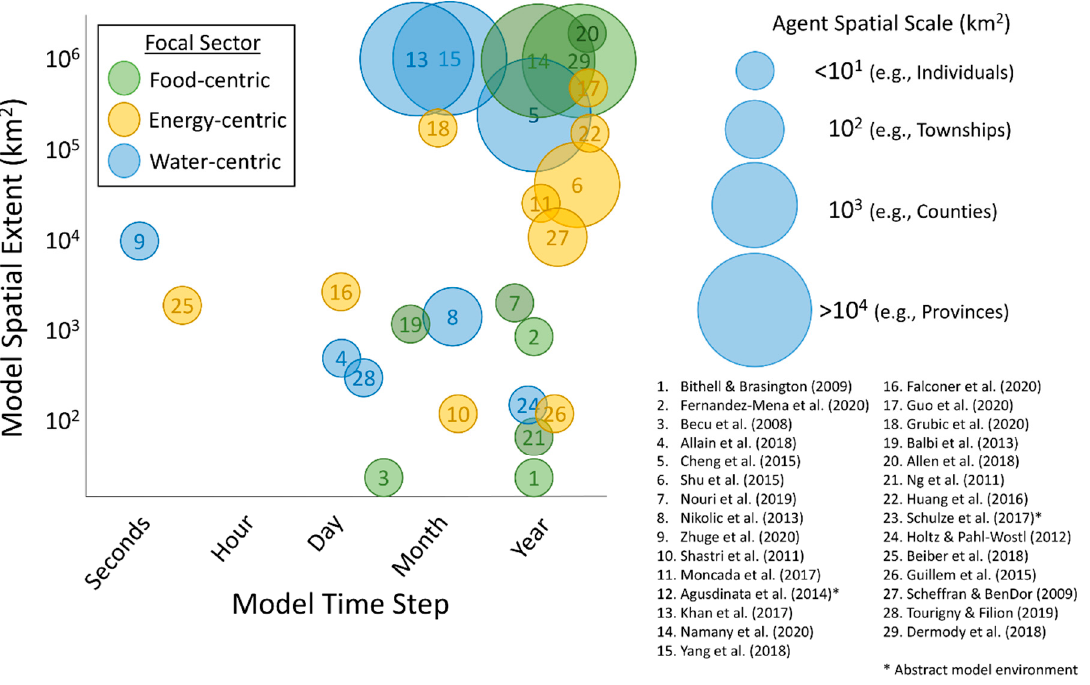
Figure 3. Configurations of model spatial extents and time steps and spatial scales of agents represented in agent-based model (ABM) application in food–energy–water system (FEWS) research. Circle size indicates the spatial scale of agent representations, and circle color is associated with the FEWS sector perspective from which the ABMs were designed. Notes: (1) when two or more models possessed the same spatial extent and time step, circles were offset to reduce occlusion. (2) ABM applications indicated with an asterisk implemented non-spatial, abstracted model environments, and thus were not plotted in the figure.